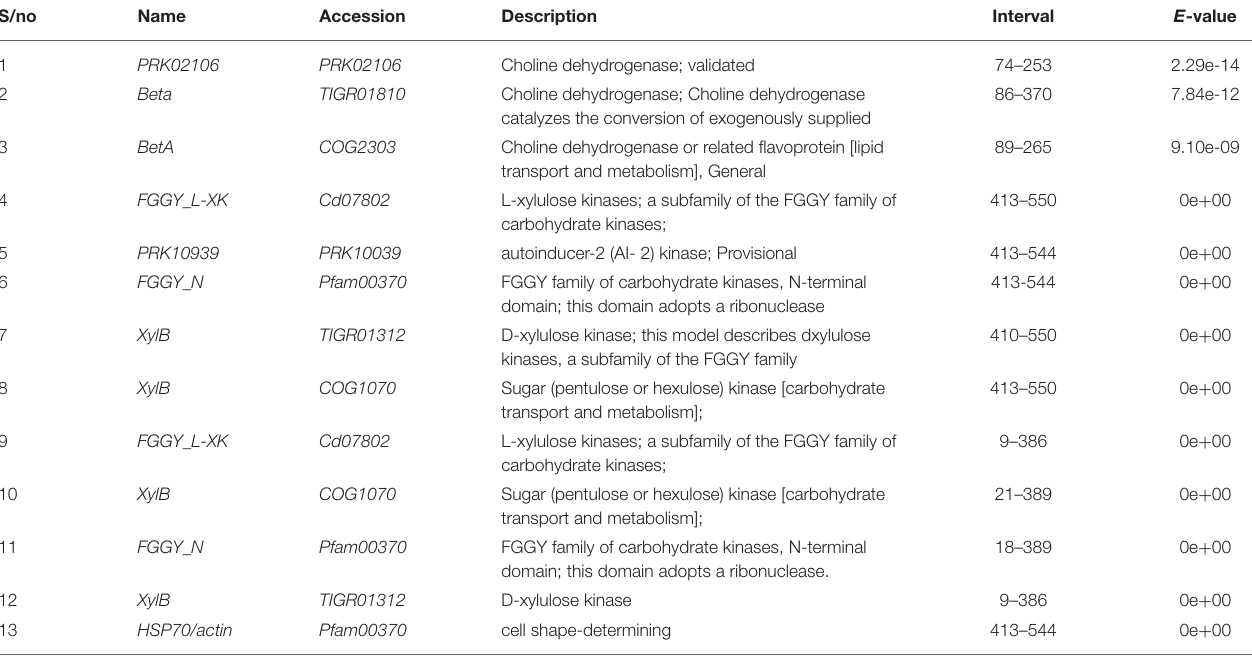
TABLE 7 | Virulence effector genes identified from Fusarium oxysporum f.sp. elaeidis 4 and CRT post inoculation of tolerant and susceptible oil palm